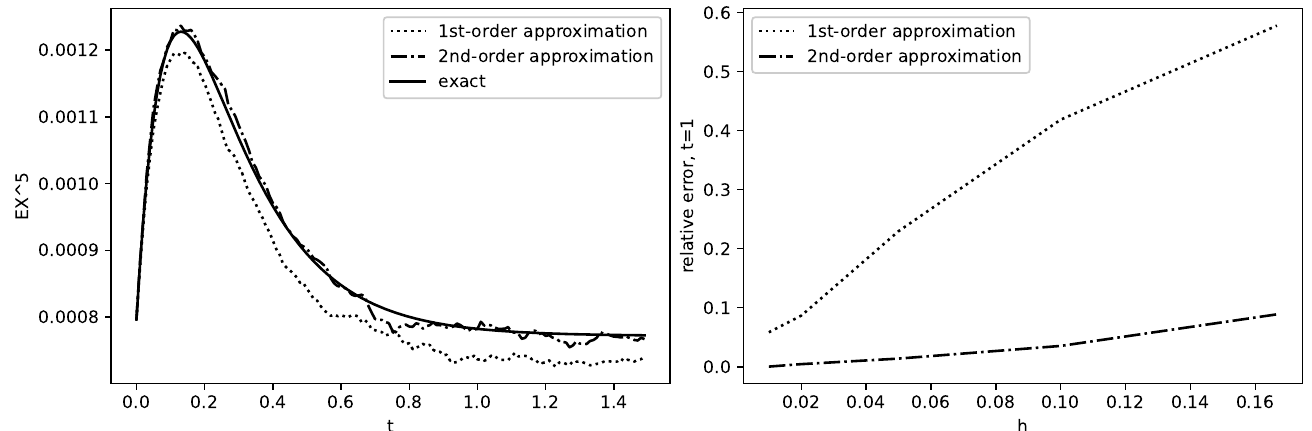
Figure 7. Comparison of E f ( ˆ X x σ 2 = 0.6, a = 0.8, b = 5, the number of iterations N = 100,000. Left : h = 0.01; Right : the relative error at t = 1.